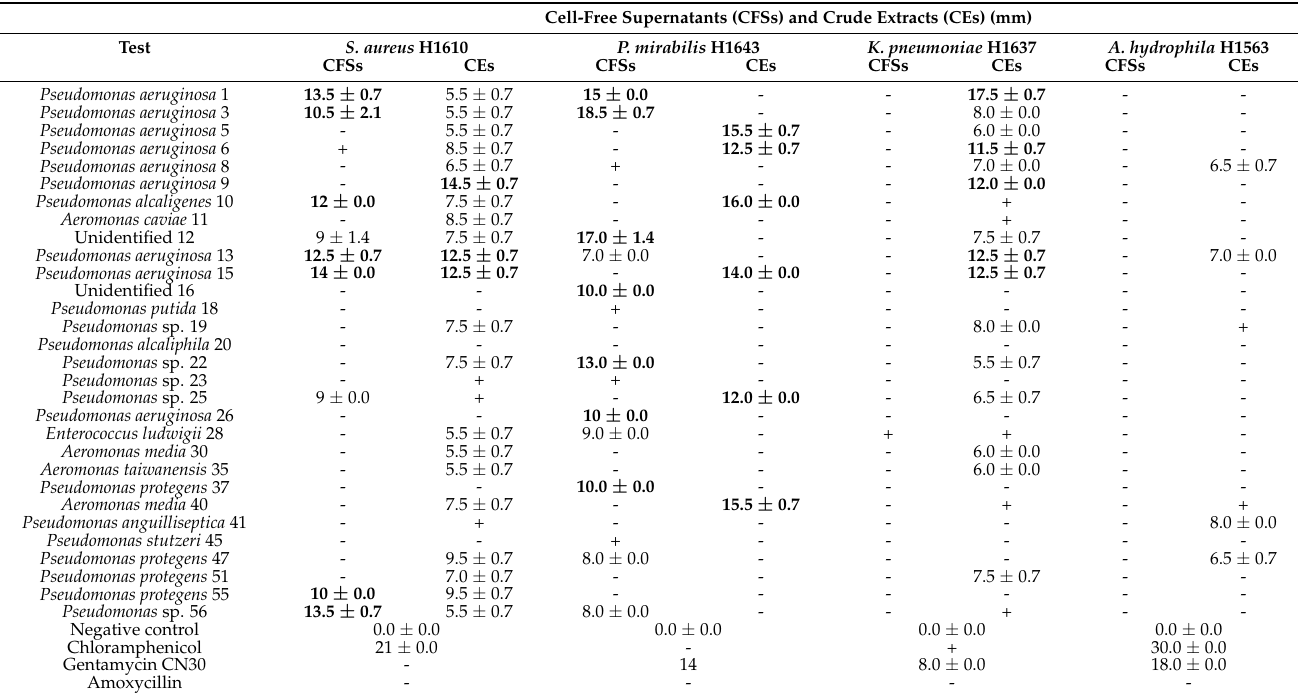
Table 2. Antibacterial activity of supernatants and crude extracts (mm) in agar diffusion assay against bacterial pathogens. Values are expressed as the mean ± standard deviation of three replicates. Highest values are highlighted in